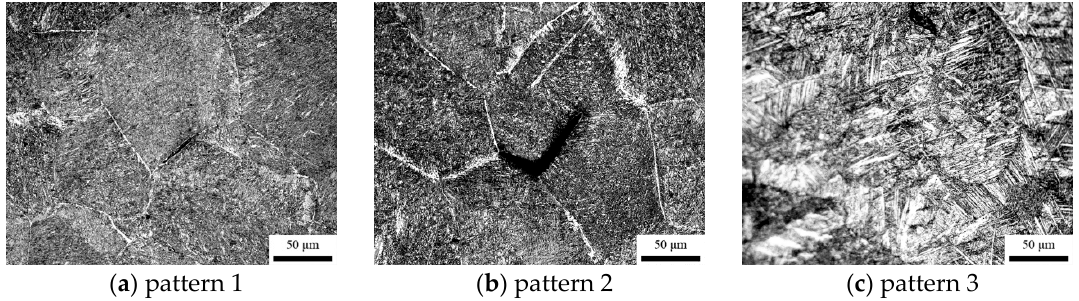
Figure 12. Etched microstructure at 800 °C under different thermal schedules.